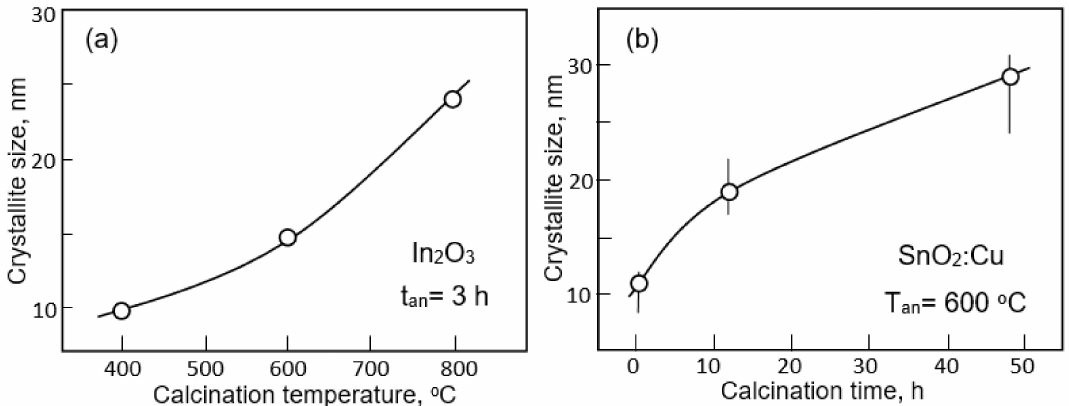
Figure 9. Influence of annealing ( a ) temperature (400–800 ◦ C) and ( b ) time (0.5–48 h) on the crystallite size in ( a ) In 2 O 3 and ( b ) SnO 2 :Cu nanofibers synthesized by electrospinning. ( a ) Data extracted from [171]; ( b ) Reprinted from